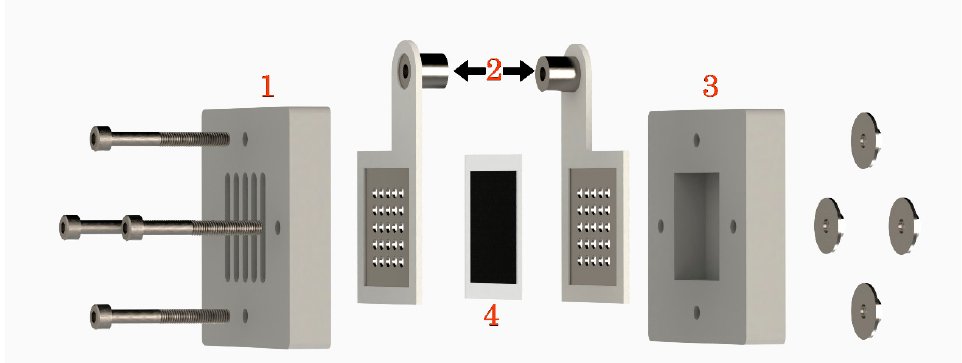
Figure 2. Fuel cell exploded view. 1. cathodic compartment (PMMA), air entrance; 2. current